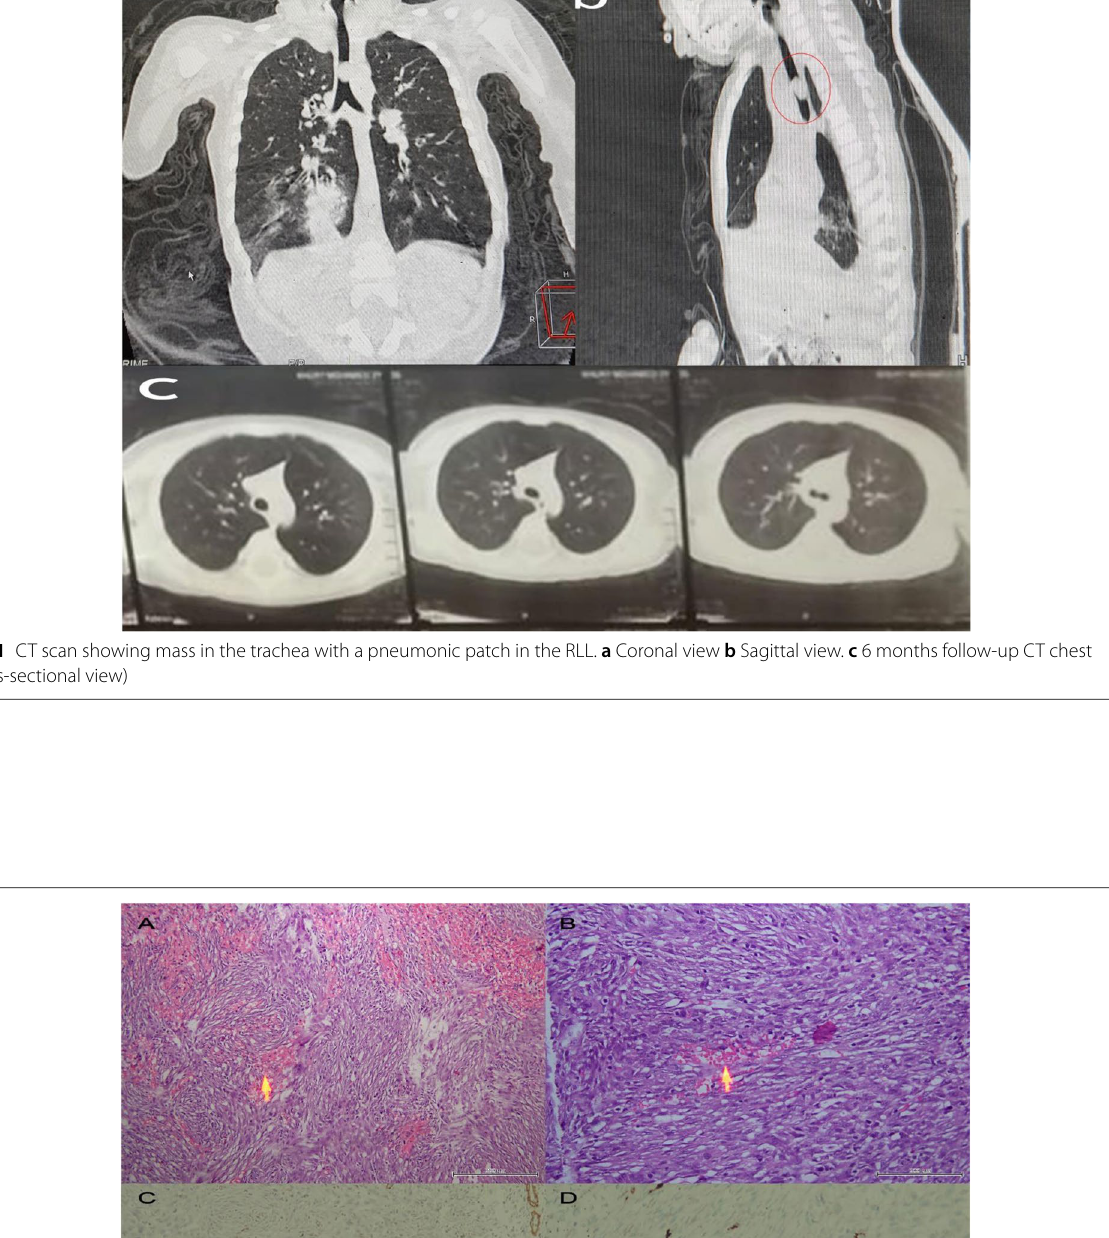
100. D CD10 positive immunostaining of cells of nodular fasciitis. = ×